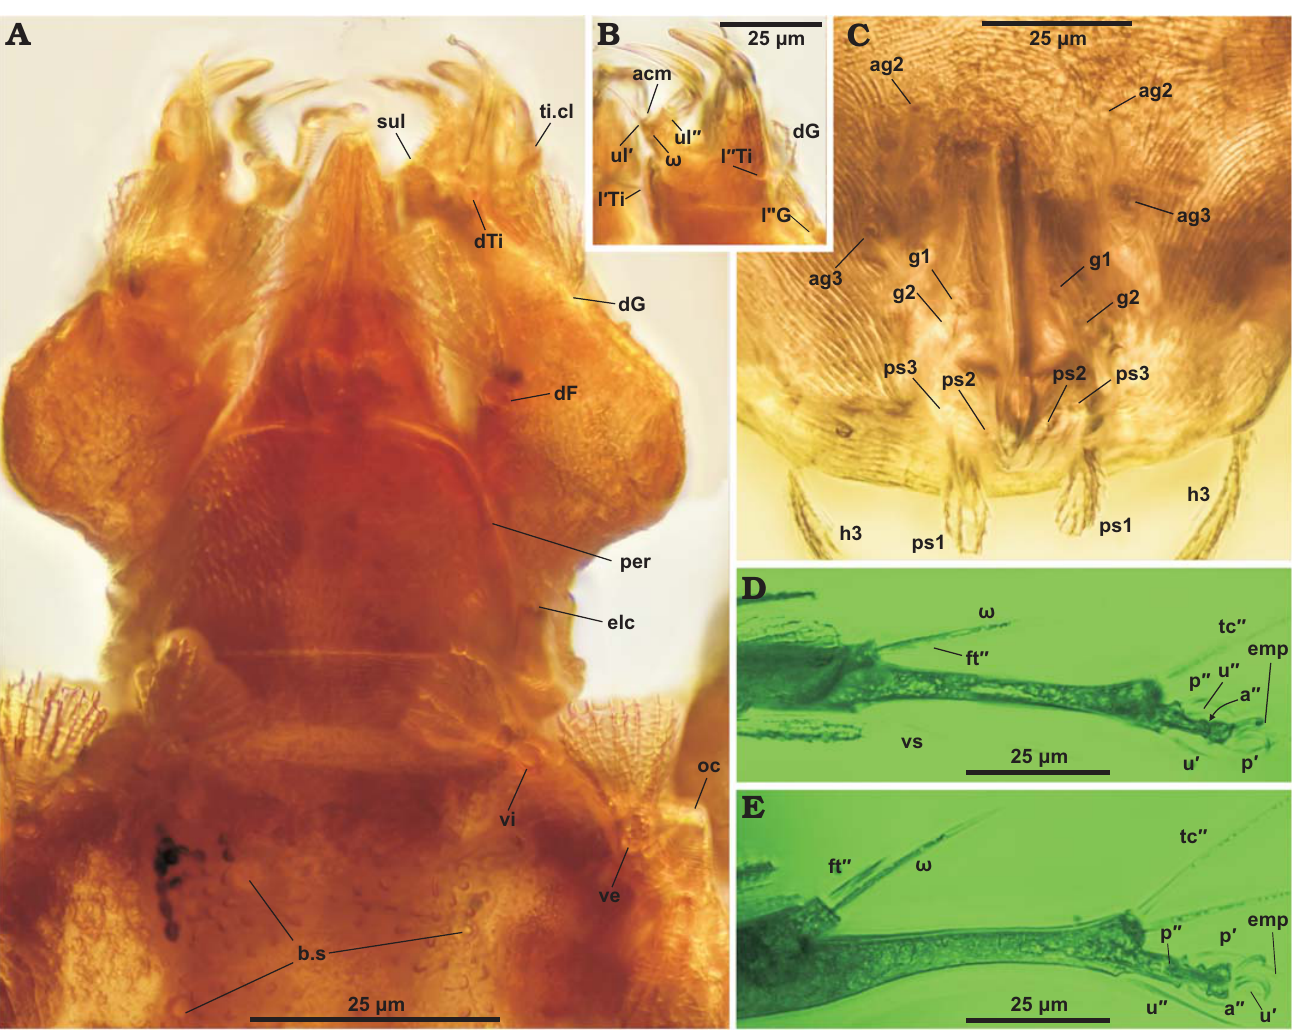
Fig. 3. Cheyletid mite Cheletomimus crinitus sp. nov., female holotype (SMF Be 2537, ex. CCHH 448-1) from Baltic amber (Baltic Sea coast, most likely Sambian Peninsula, middle to upper Eocene, 37–54.5 Mya). A . Dorsal view of gnathosoma and anterior opisthosoma (micropanorama assembled from ca 80 images). B . Detail of left palp in ventral view (assembled from 18 images). C . Posterior of ano-genital area in lateral antiaxial view in lateral